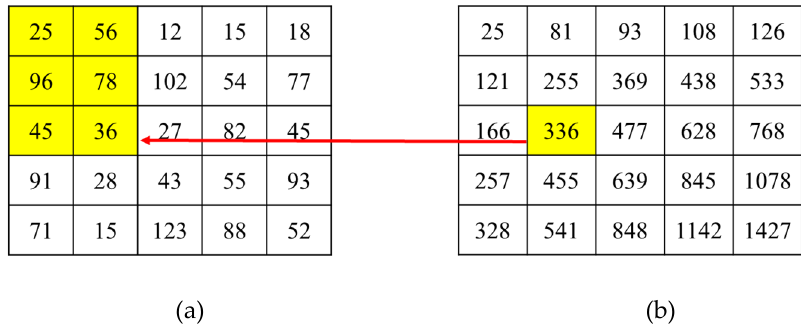
Figure 5. Example of integral image calculation: (a) grayscale image, (b) integral image.